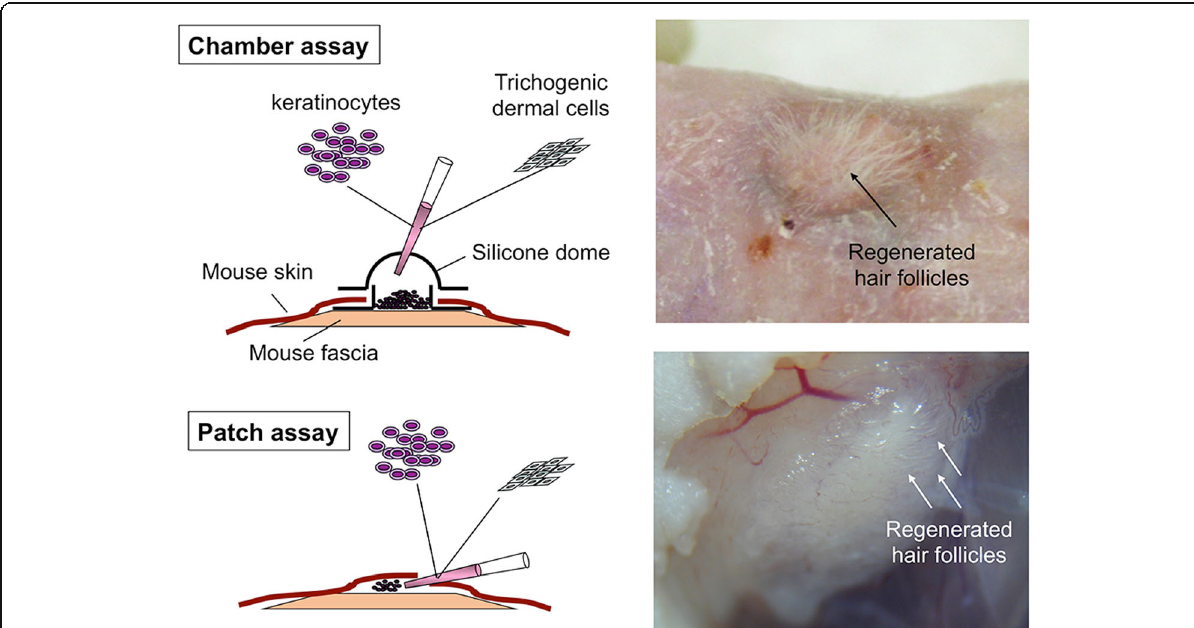
Fig. 4 Approaches for HF regeneration in vivo. In the chamber assay, mixture of keratinocytes and trichogenic dermal cells are transplanted into a silicone chamber on the back of immunodeficient mice. In the patch assay, cell mixture is directly injected into the hypodermis of immunodeficient